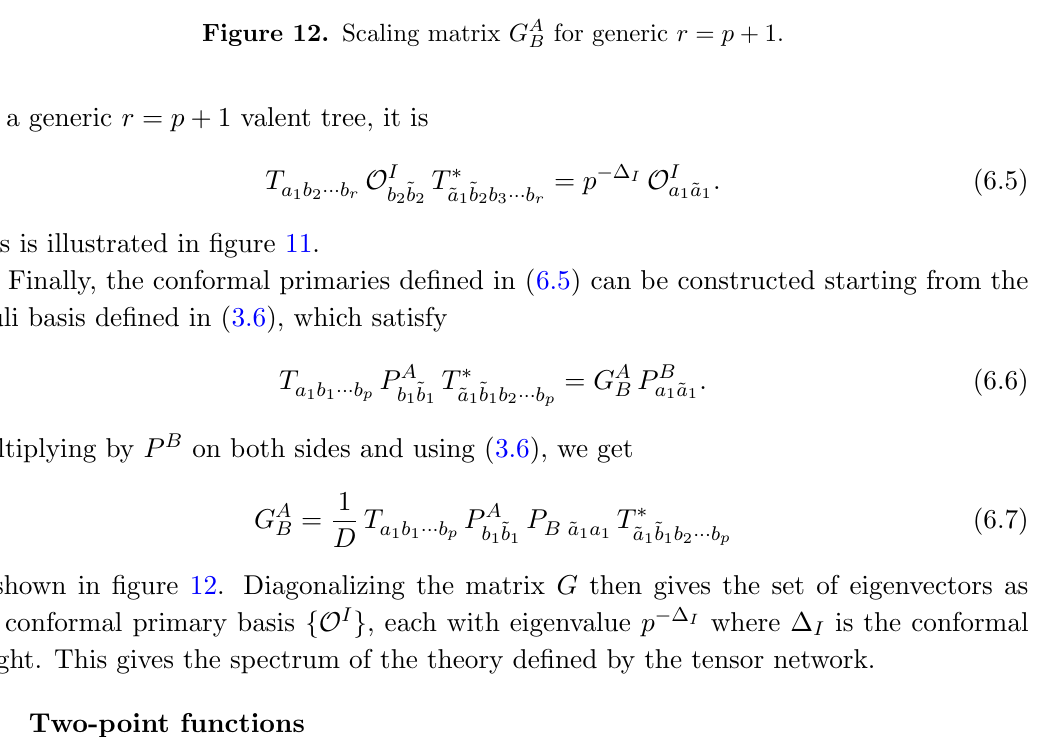
Figure 12. Scaling matrix G A